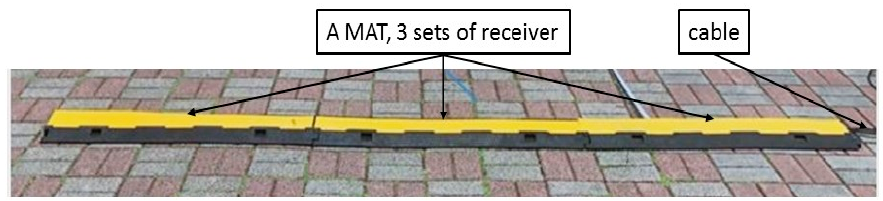
Figure 5. A MAT with a set of three BLE Receivers.